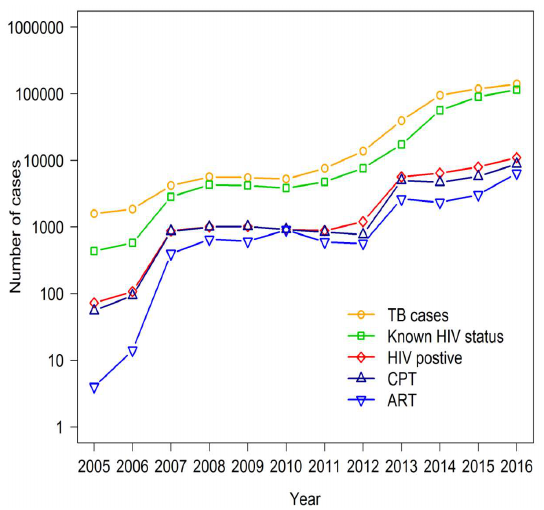
Figure 4. Trends of TB/HIV service cascade in number of cases (2005–2016). Note: Data included government and non-government sector. CPT: HIV-positive TB patients who received CPT; ART: HIV-positive TB patients who received ART.